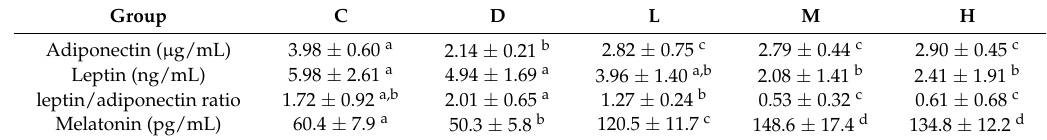
Table 7. Effect of melatonin on plasma adipokines after the six-week melatonin intervention.